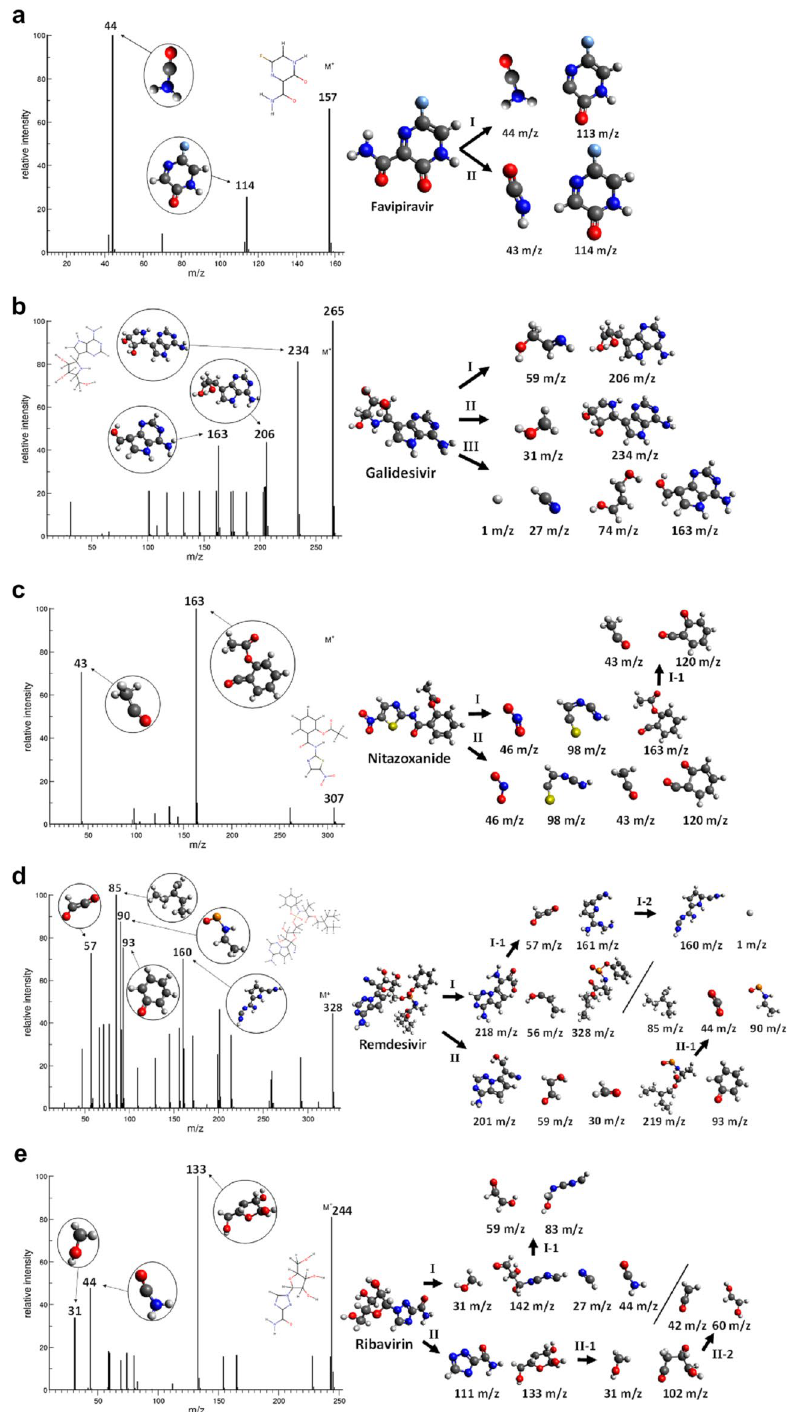
Figure 2. EI-MS fragmentation spectra and trajectories of ( a ) Favipiravir, ( b ) Galidesivir, ( c ) Nitazoxanide, ( d ) Remdesivir and ( e )